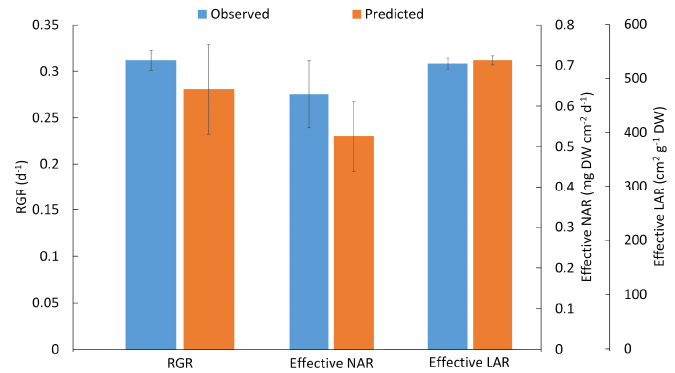
Figure 6. Relative growth rate (RGR), net assimilation rate (NAR), and leaf area ratio (LAR) calculated from observed and predicted dry weight and plant area values. Values are means of indices calculated with data from each experimental replicate ( n = 4). Error bars show standard errors of the mean